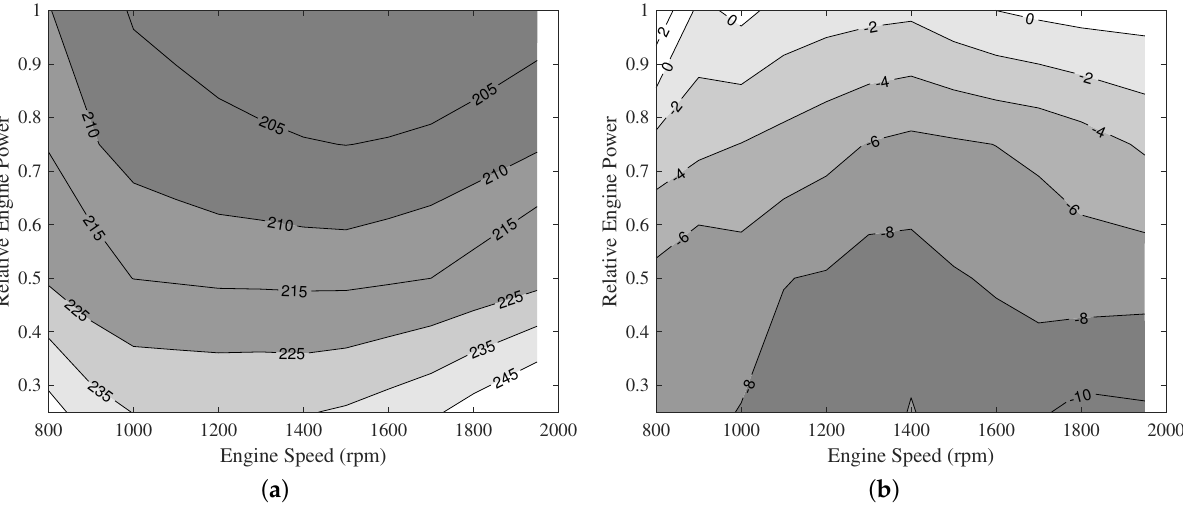
Figure 5. Results obtained from AGCO Power 49 engine model. ( a ) Specific fuel consumption (g/kWh) map calculated by the model. ( b ) Percentage differences between calculated and measured values of b e